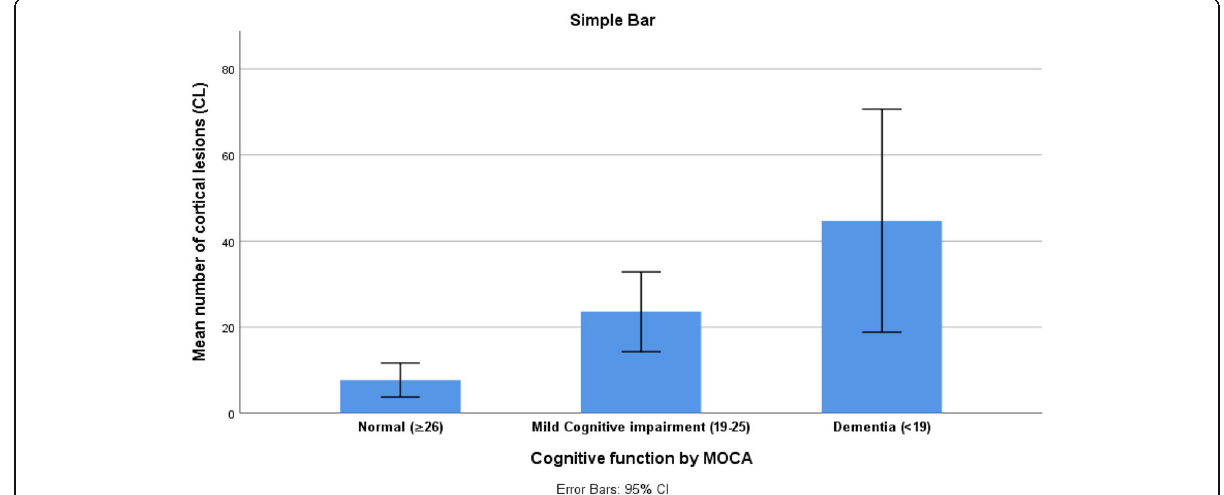
Fig. 4 Simple bar chart revealing mean CL numbers in different cognitive status assessed by MoCA test